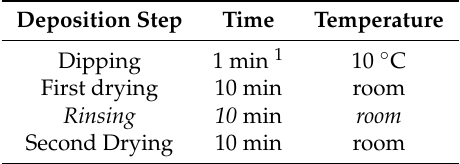
Table 4. Fabrication step details of the optimized deposition procedure.